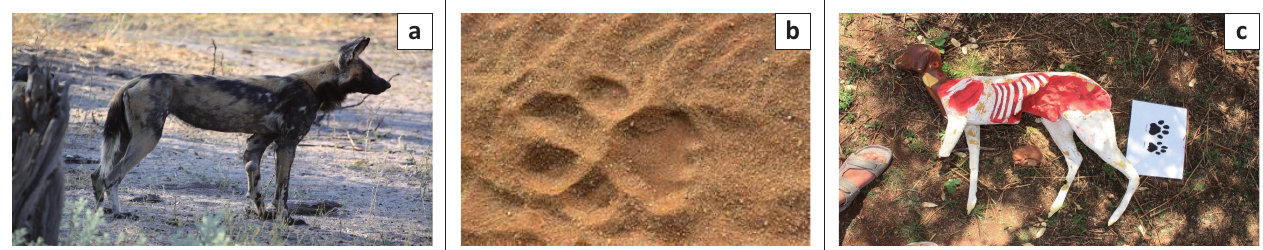
FIGURE 2: Examples of cards used to assess herders’ skills to identify carnivores. (a) Visual, (b) track and (c) kill